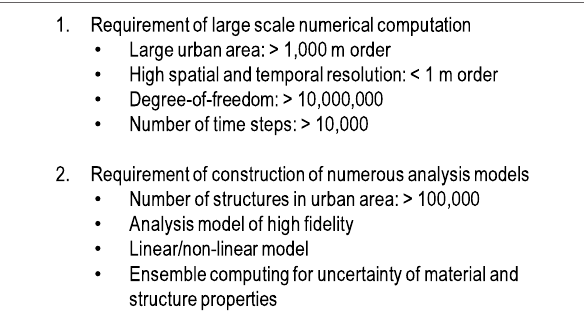
FigUre 2 | Two requirements in applying numerical simulation to estimation of earthquake hazard and